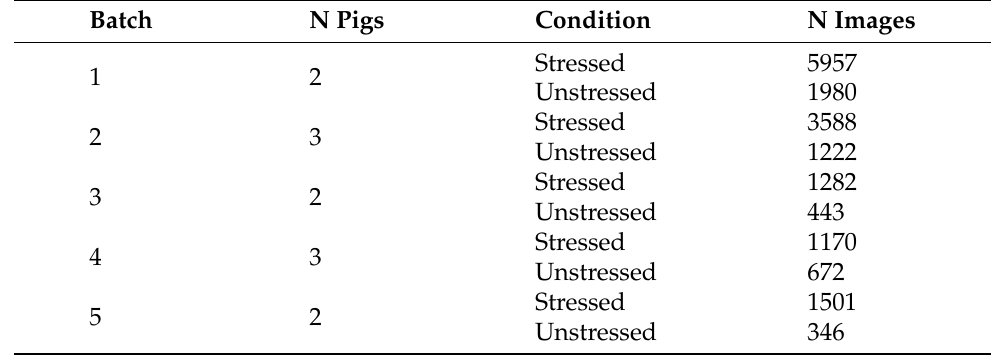
Table 1. The statistics of the full dataset after cleaning showing how many pigs (N Pigs), and the number of images (N Images) for each condition are present in each batch.